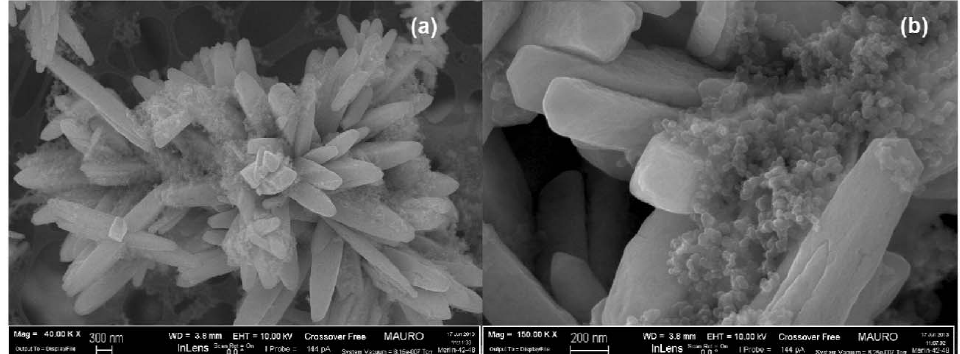
Figure 4. FESEM images representing a loose contact mixture of CeO 2 SA-stars and soot at × 40,000 ( a ) × 150,000 ( b ) level of magnifications. Reproduced from Ref. [92] with the permission from the Royal society of chemistry.